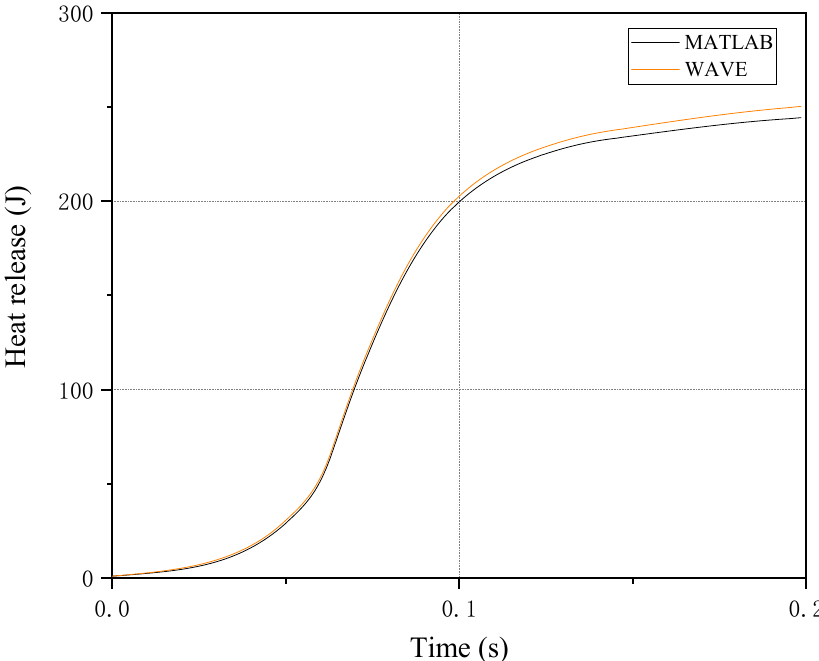
Figure 10. Heat release rate comparison between MATLAB and WAVE.